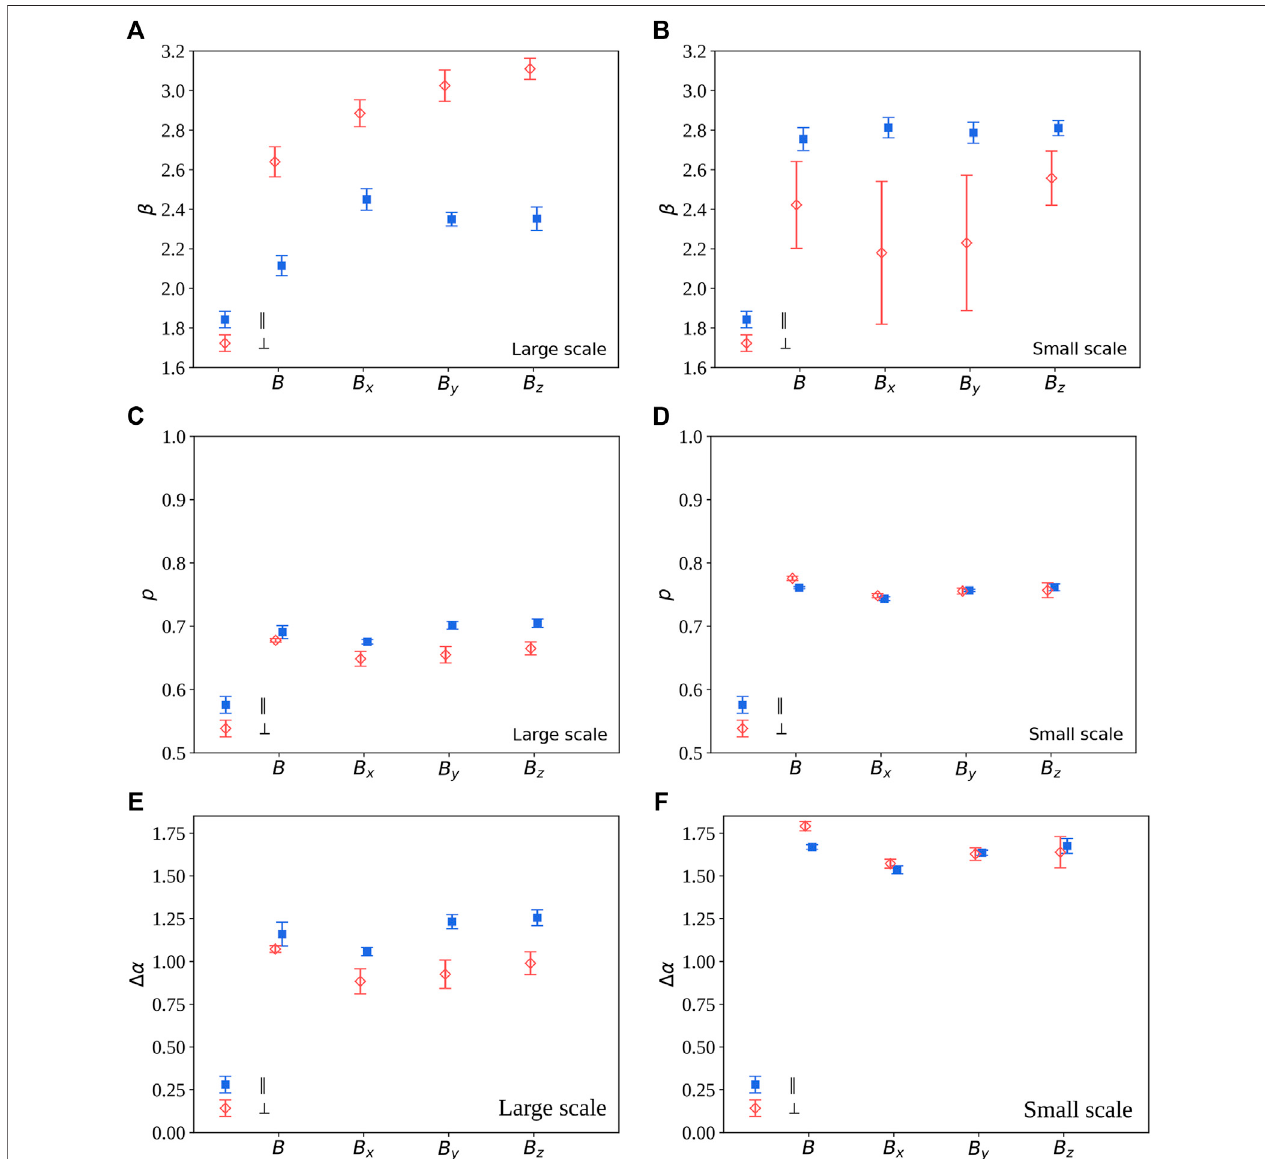
FIGURE 5 | Visualization of the spectral exponent β (A,B) , of the P-model parameter p (C,D) , and of the multifractal width Δ α (E,F) , obtained for the magnetic fi eld components in both intervals. Different colors and symbols refer to quasi-parallel (blue squares) and quasi-perpendicular (red diamonds) sub-intervals. Values are averaged over the four spacecraft, the error bar being the standard deviation. (E) refer to the large-scale range, (F) to the small-scale range.